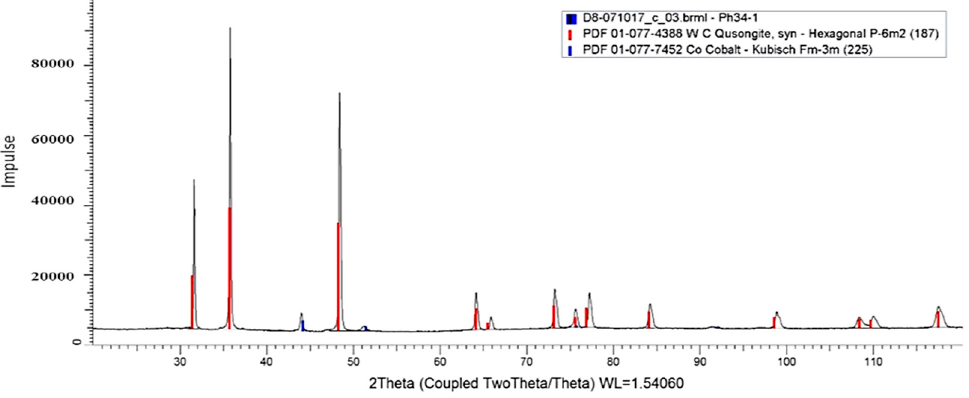
Figure 17. X-ray di ff raction (XRD) pattern of substrate SH-5. Figure 17. X-ray diffraction (XRD) pattern of substrate SH-5. Figure 17. X-ray diffraction (XRD) pattern of substrate SH-5.